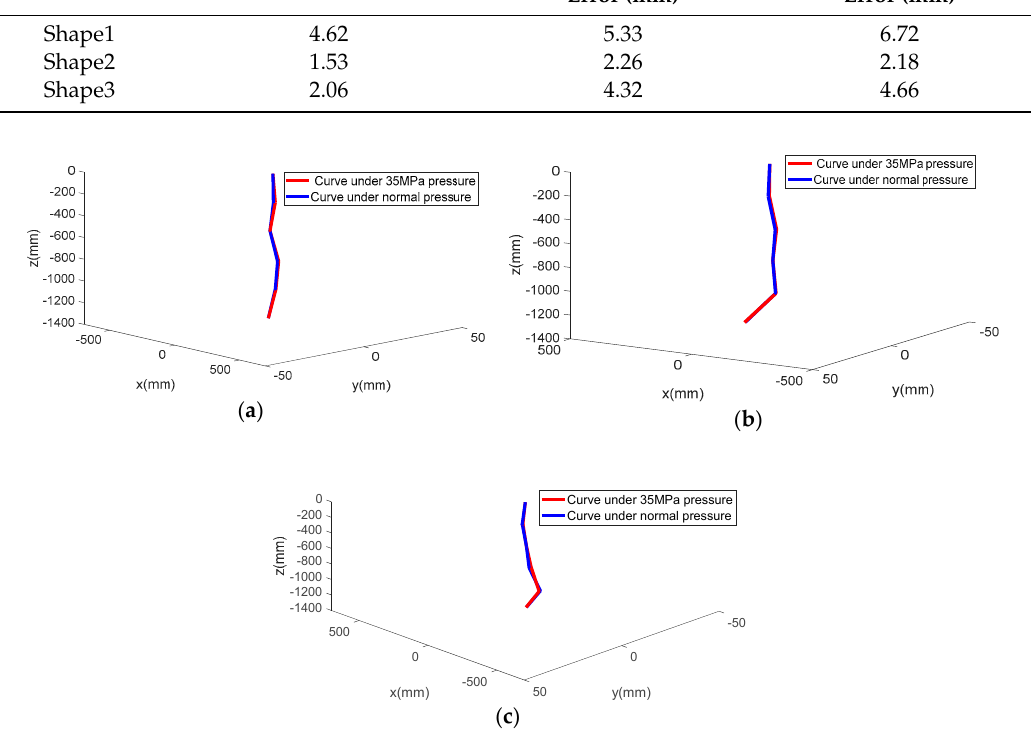
Figure 11. ( a ), ( b ), and ( c ) are the curves obtained from the two states. Red lines are the measurement curves from the MEMS accelerometers under 35 MPa pressure and blue lines are the measurement curves from the MEMS accelerometers under normal pressure. Table 1. The measurement errors.